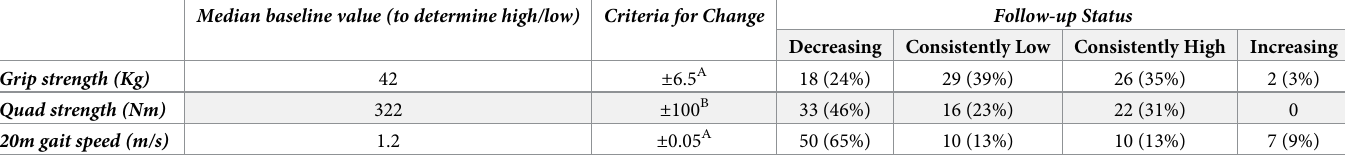
Table 3. Change in physical function among PC cases at 3–4 years post-diagnosis. Median baseline value (to determine high/low) Criteria for Change